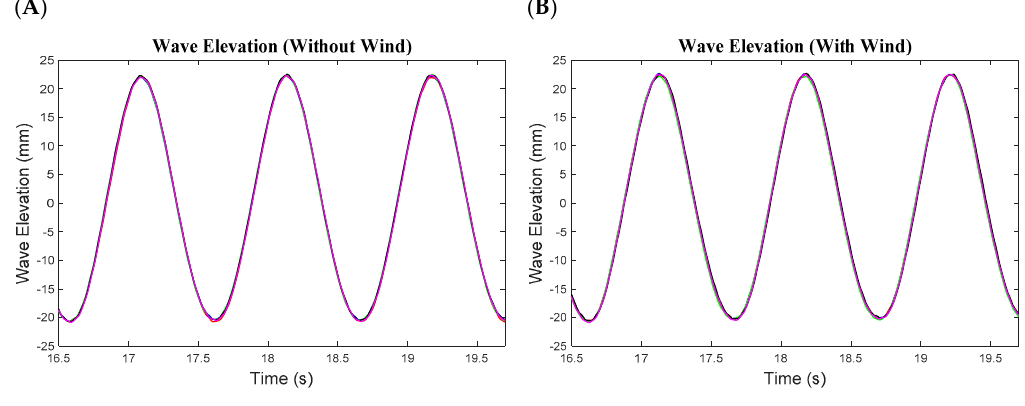
Figure 9. Time history of wave elevation at WP2 and the selected time window for data